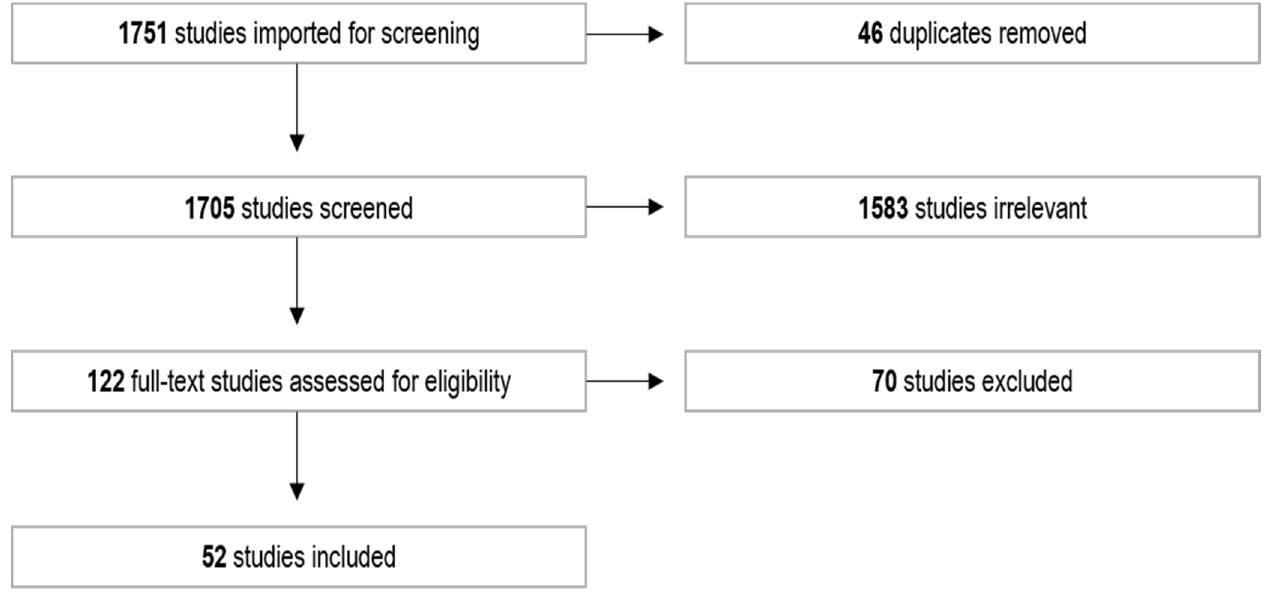
Figure 1. PRISMA flow chart showing the screening process for the scoping review.